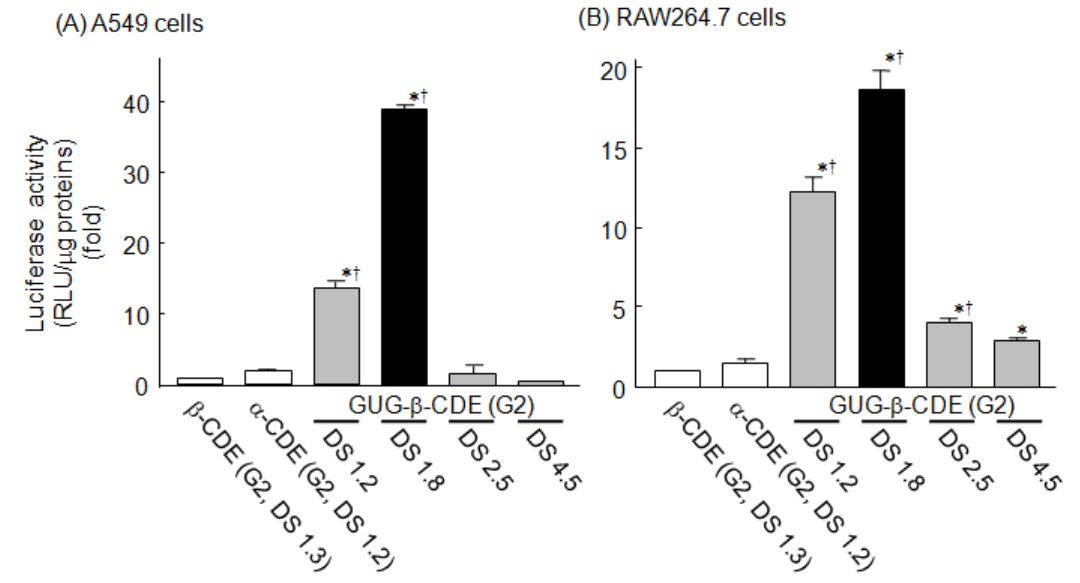
Figure 3. Transfection efficiencies of the pDNA complexes with α -CDE (G2, DS 1.2), β -CDE (G2, DS 1.3) and GUG- β -CDEs (G2, DS 1.2, 1.8, 2.5 or 4.5) in A549 cells and RAW264.7